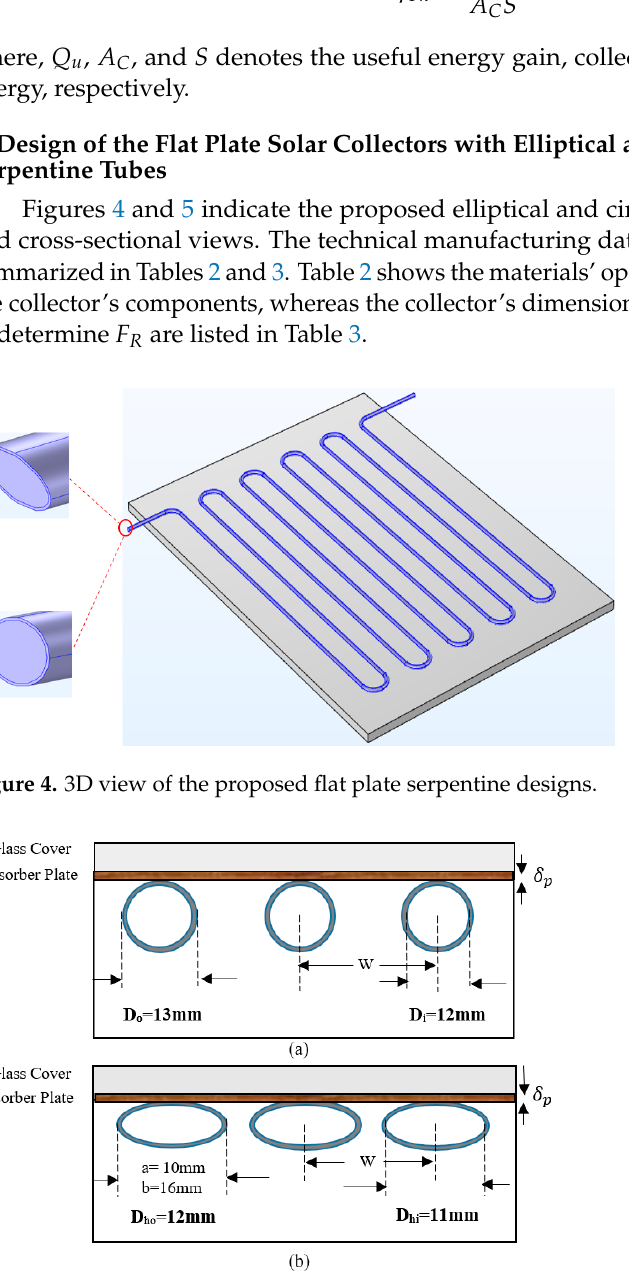
Figure 5. The cross-section view is ( a ) a circular serpentine tube and ( b ) an elliptical serpentine tube.